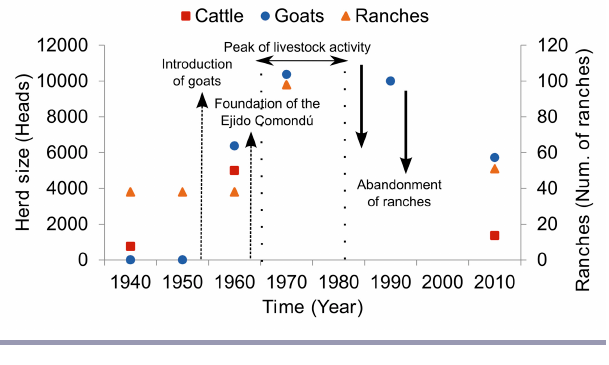
Fig. 10 . Rainfall, droughts, and hurricanes. The years with rainfall that was less than the average annual rainfall rate are considered drought years. Hurricanes are indicated with dotted lines. The official register of hurricanes in Baja California Sur started in 1966. Hurricane wind categories are as follows: H5 (> 135 knots), H4 (114–135 knots), H3 (96–113 knots), H2 (83–95 knots), H1 (64–82 knots), TS (tropical or subtropical storm; 34–63 knots), TD (tropical depression; < 34 knots), and ET